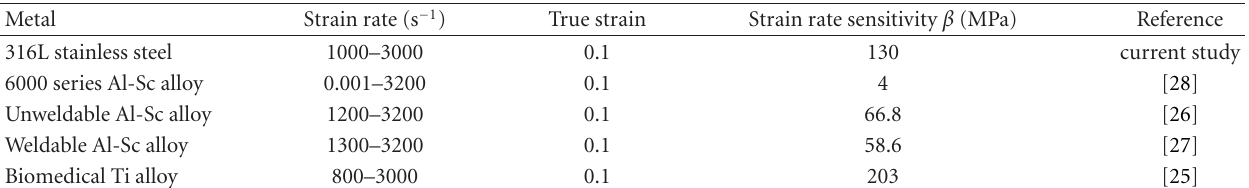
Table 3: Strain rate sensitivity of various alloys at 25 ◦ C.